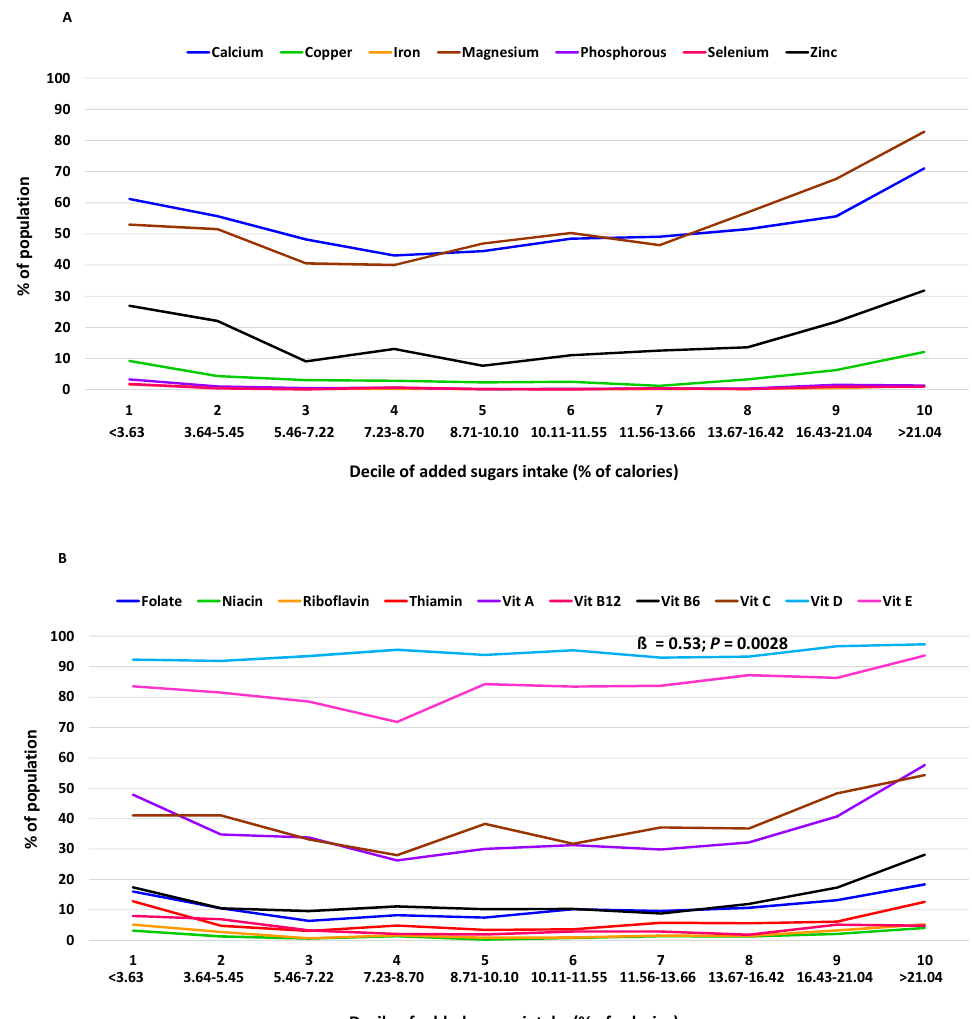
Figure 3. Percentage of adults 51 + y (NHANES 2009–2014) with micronutrient intakes below the EAR for ( A ) minerals and ( B ) vitamins per decile of added sugars intake (% of calories) averaged across two days of intake using regression analysis (ß: regression coefficient). Association deemed significant at p < 0.01. EAR, Estimate.